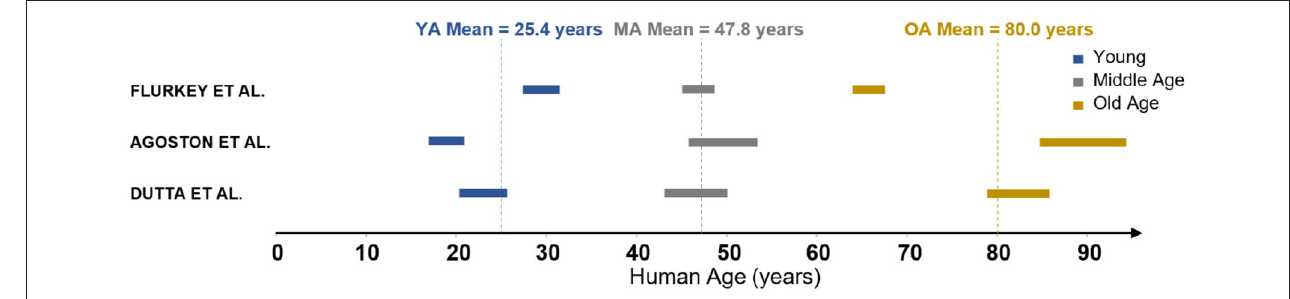
FIGURE 1 | Mouse-human age conversion identified in the